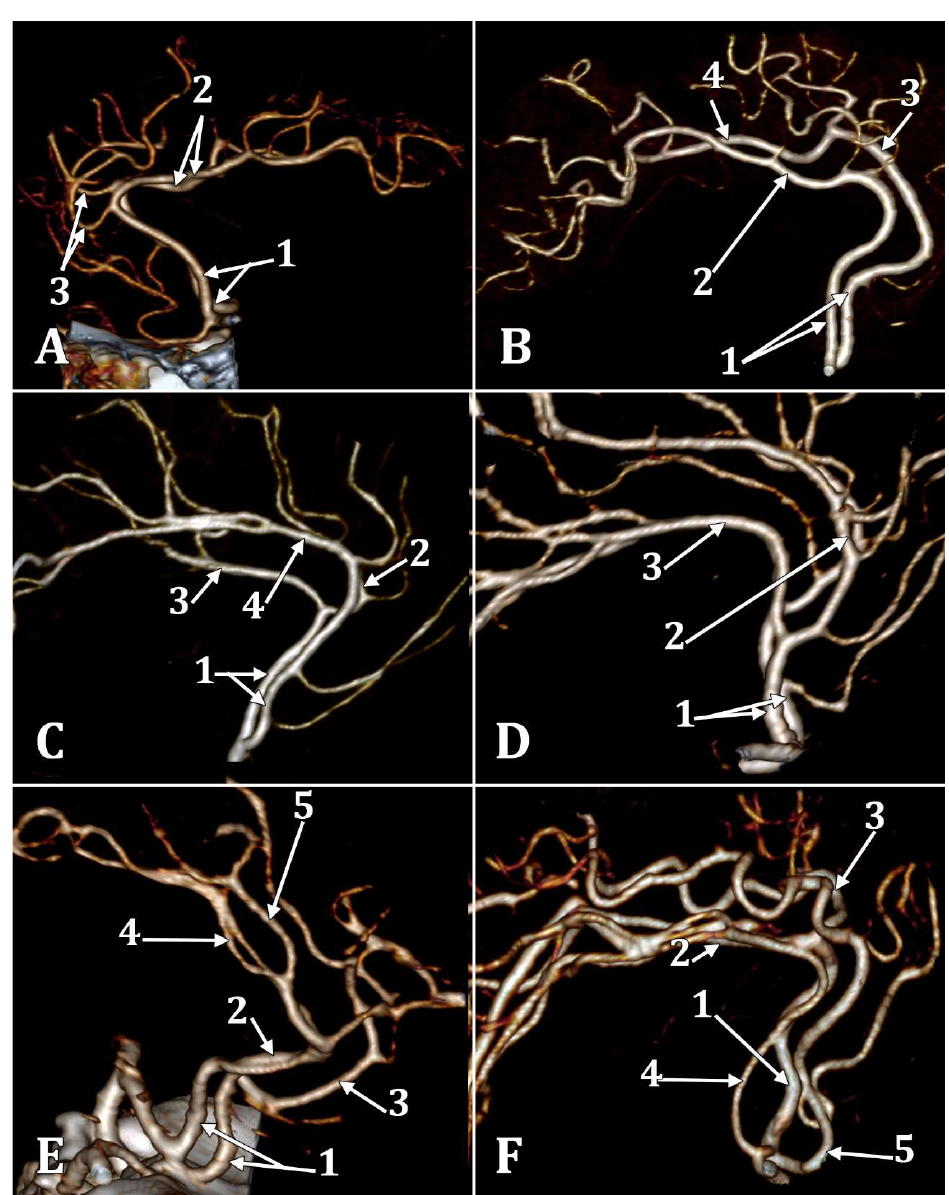
Figure 1. Three-dimensional volume renderings of different types of different branching types of the anterior cerebral arteries (ACAs) into the pericallosal (PCalA) and callosomarginal (CMA) arteries. ( A ) Left antero-lateral view: 1 A2 segments of the ACAs; 2. type 1 PCalAs; 3. type 1 CMAs. ( B ) Right lateral view: 1. A2 segments of the ACAs; 2. type 10 right PCalA (PCalA type of ACA); 3. type 4 left CMA, at the level of the cingulate sulcus; 4. type 8 left PCalA. ( C ) Right lateral view: 1. A2 segments of the ACAs; 2. left type 1 CMA; 3. left type 1 PCalA; 4. right type 1 CMA, type 7 (absent) right PCalA. ( D ) Right lateral view: 1. A2 segments of the ACAs; 2. type 3b of the right CMA; 3. type 2b of the right PCalA. ( E ) Right antero-lateral view: 1. A2 segments of the ACAs; 2. type 2a of the left PCalA; 3. type 3a of the left CMA; 4. type 3 of the right PCalA; 5. type 2 right CMA. ( F ) Right lateral view: 1. A2 segment of the left ACA; 2. left type 1 PCalA; 3. left type 1 CMA; 4. type 2a right PCalA; 5. type 3a right